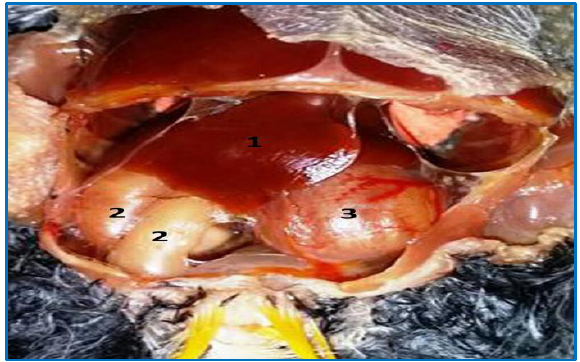
Figure, 2: Shape and position of small intestine of whited eared bulbul (1) liver right lobe, (2) gizzard, (3)small intestine.